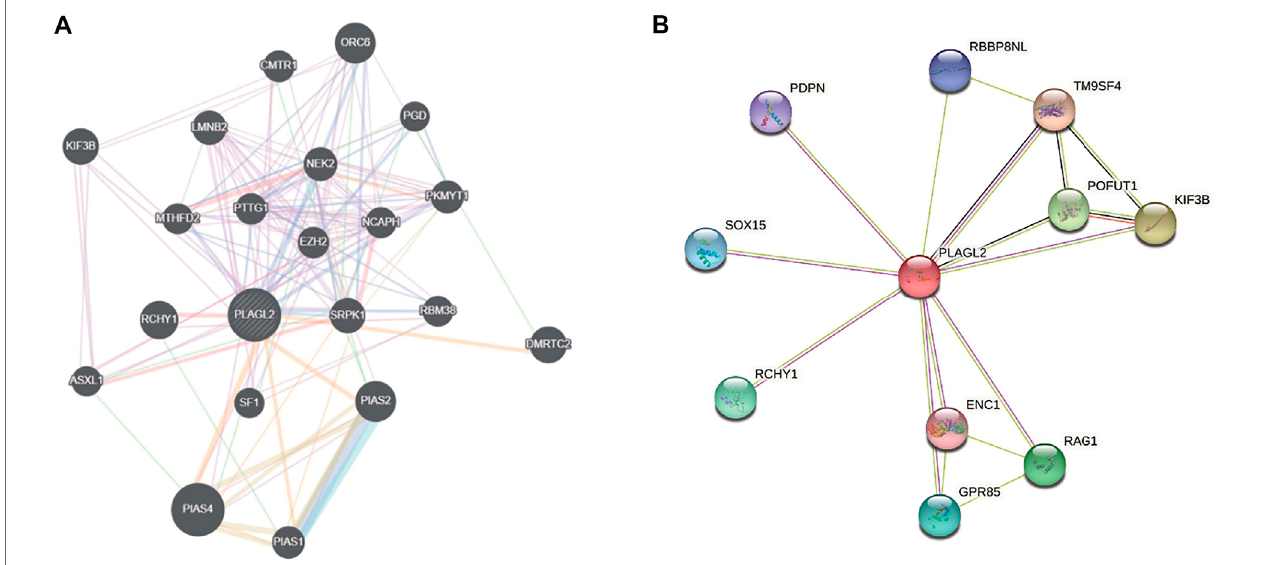
FIGURE 7 | Interaction network of PLAGL2 gene arisen from GeneMANIA and STRING database. (A) based on physical and genetic interactions, pathway analysis, co-expression, and localization, GeneMANIA performed the interactions for PLAGL2 linked with each other. (B) The protein interaction network against PLAGL2 was conducted in the STRING